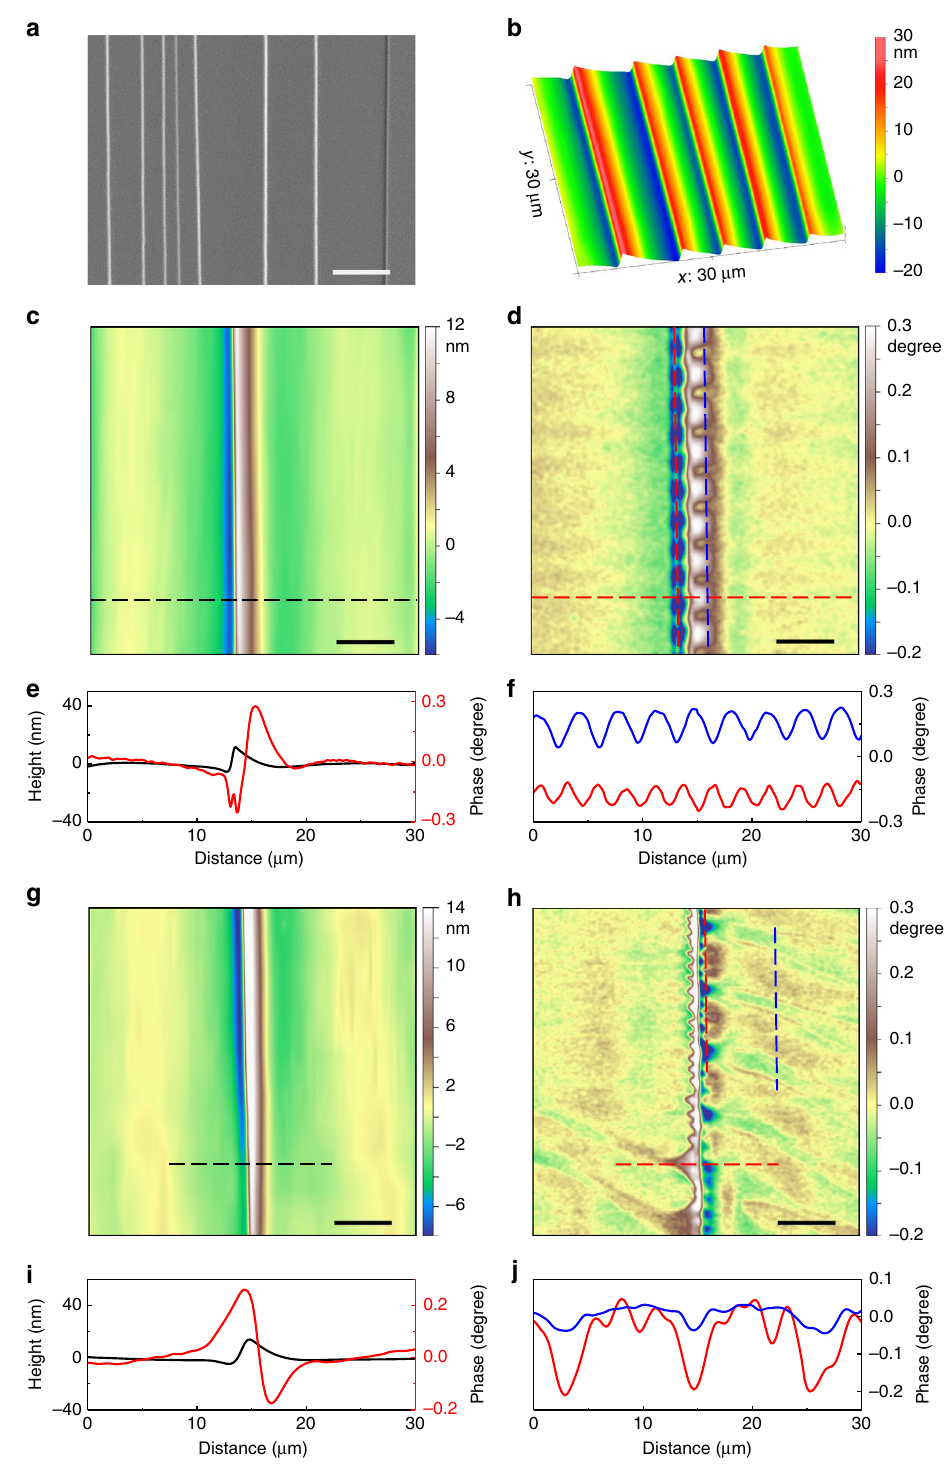
Fig. 1 Typical AFM and MFM micrographs of shear bands. a SEM image of shear bands upon bending the Fe 78 Si 9 B 13 MG ribbons. b 3D AFM topographic image of shear bands. c , d AFM topographic image ( c ) and the corresponding MFM phase image ( d ) of a single shear band. For MFM phase image, wave- like magnetic domain patterns are formed along the shear band with the light white (dark blue) regions corresponding to the magnetization pointing out of (into) the sample plane, respectively. e Height and the corresponding MFM phase pro fi les along the transverse black and red dotted lines in c and d , respectively. f MFM phase pro fi les along the lines on both sides of the shear band, as indicated by the colored dotted lines in d . g , h AFM topographic image ( g ) and the corresponding MFM phase image ( h ). For MFM phase image, wave-like magnetic domain patterns can extend tens of micrometers. i Height and the corresponding MFM phase pro fi les along the transverse black and red dotted lines in g and h , respectively. j , MFM phase pro fi les along the colored dotted lines in h . The intensity of the extending magnetic domains (blue line) is much weaker than the domains surrounding the shear band (red line). Scale bar, 5 µ m in a , c , d and 10 µ m in g ,